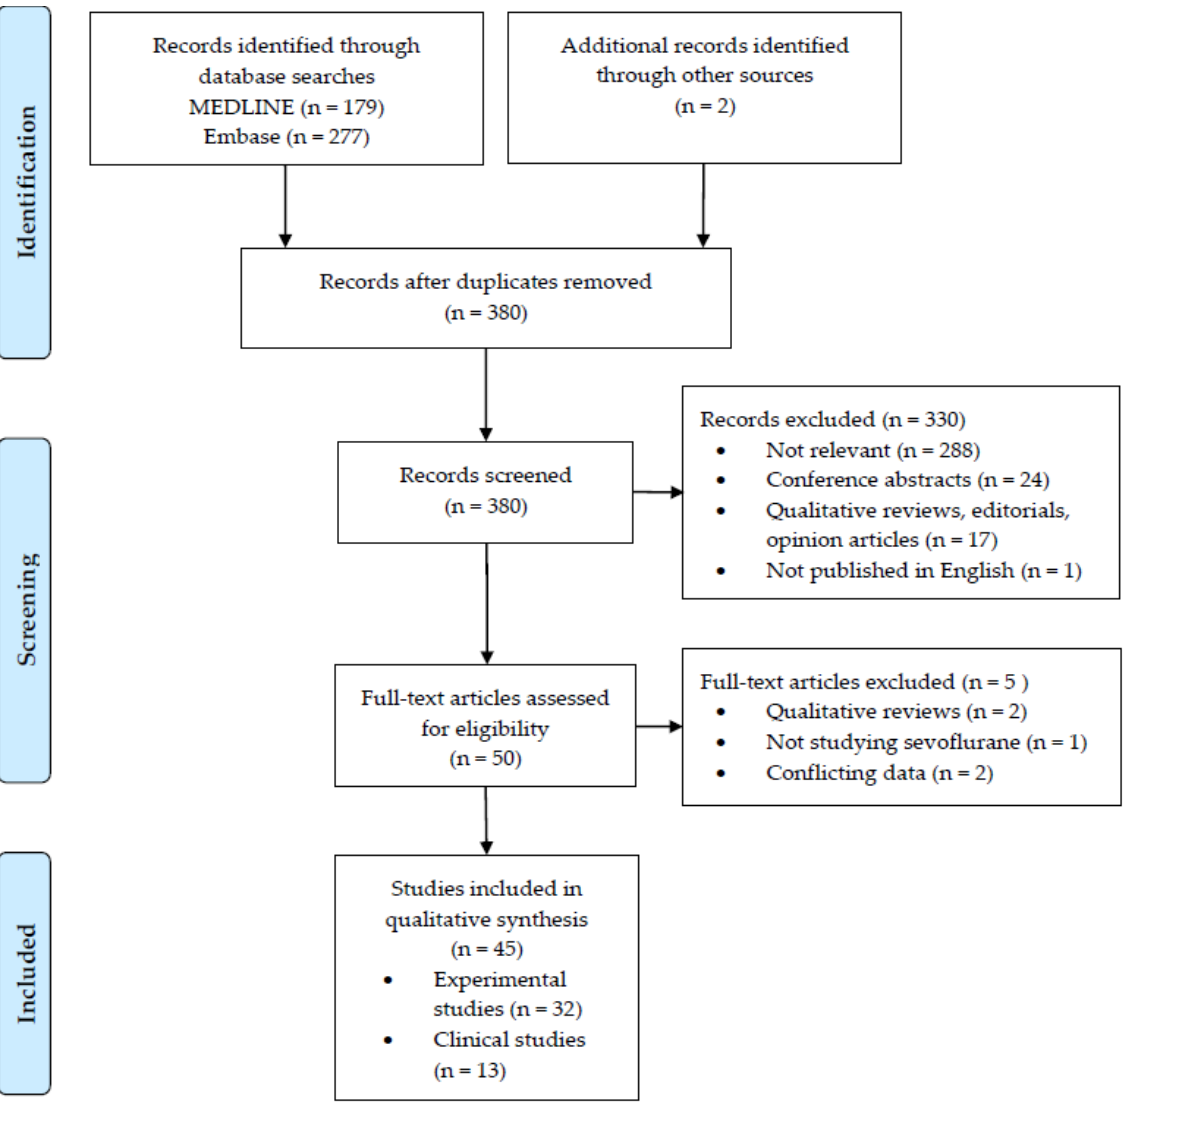
Figure 1. Study Flow Chart.